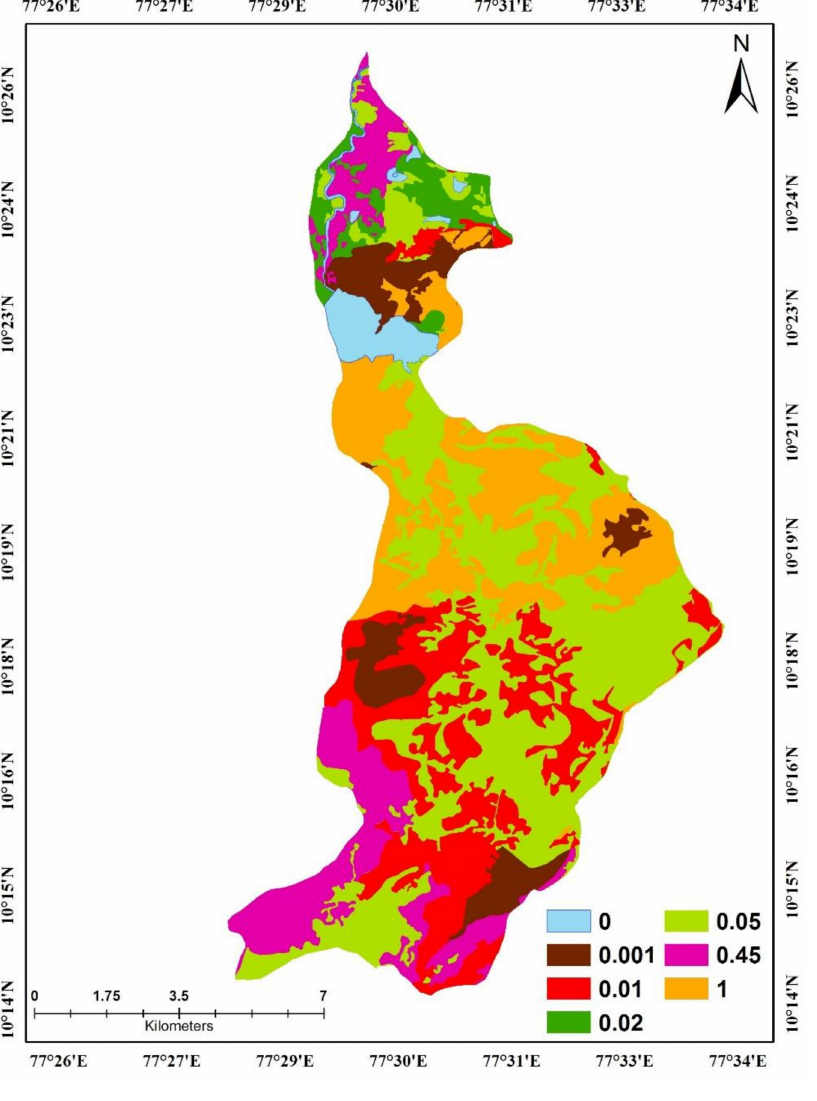
Figure 5. Crop management factor